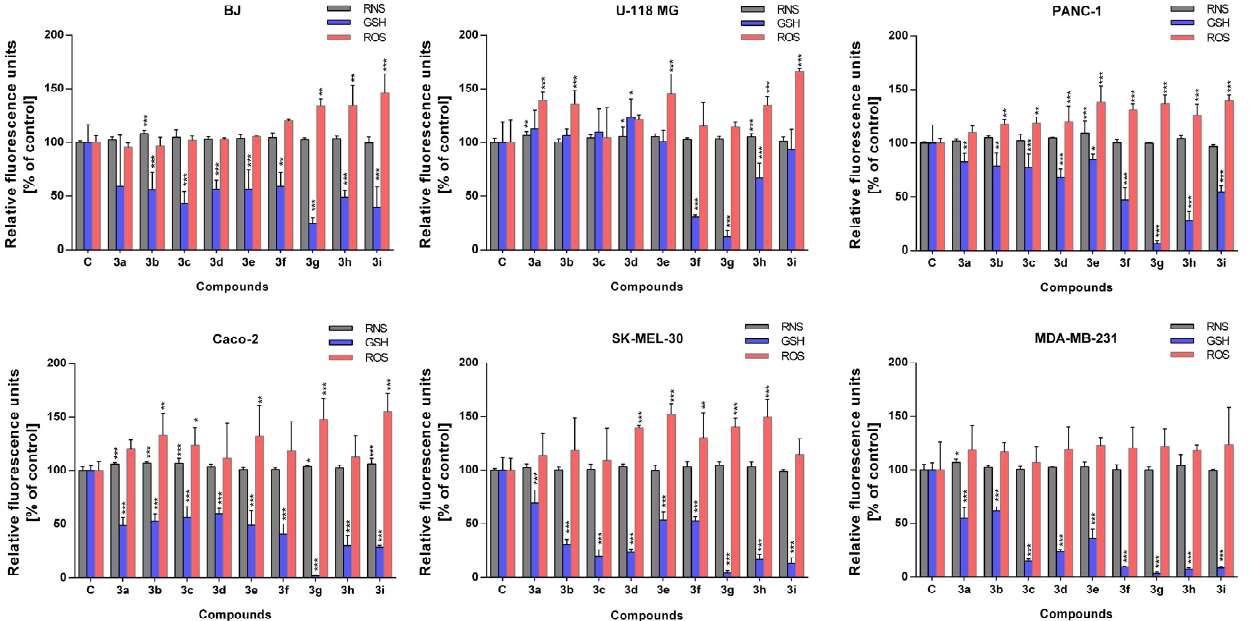
Figure 5. Redox homeostasis disruption in normal and cancer cell lines. Cells were treated with different compounds ( 3a – 3i ) in a wide range of concentrations for 72 h and redox balance was assessed by superoxide (ROS), nitric oxide (RNS) and thiol (GHS) fluorogenic probes. Bars indicate mean value and SD, n = 8, *** p < 0.001, ** p < 0.01, * p < 0.05 (one-way ANOVA and Dunnett’s a posteriori test).